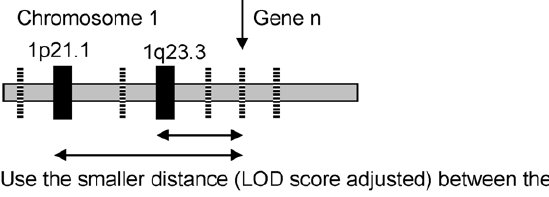
Table S1 CNV genes in EASE. The top 20 categories in EASE Table S2 Immune function gene sets from the copy number